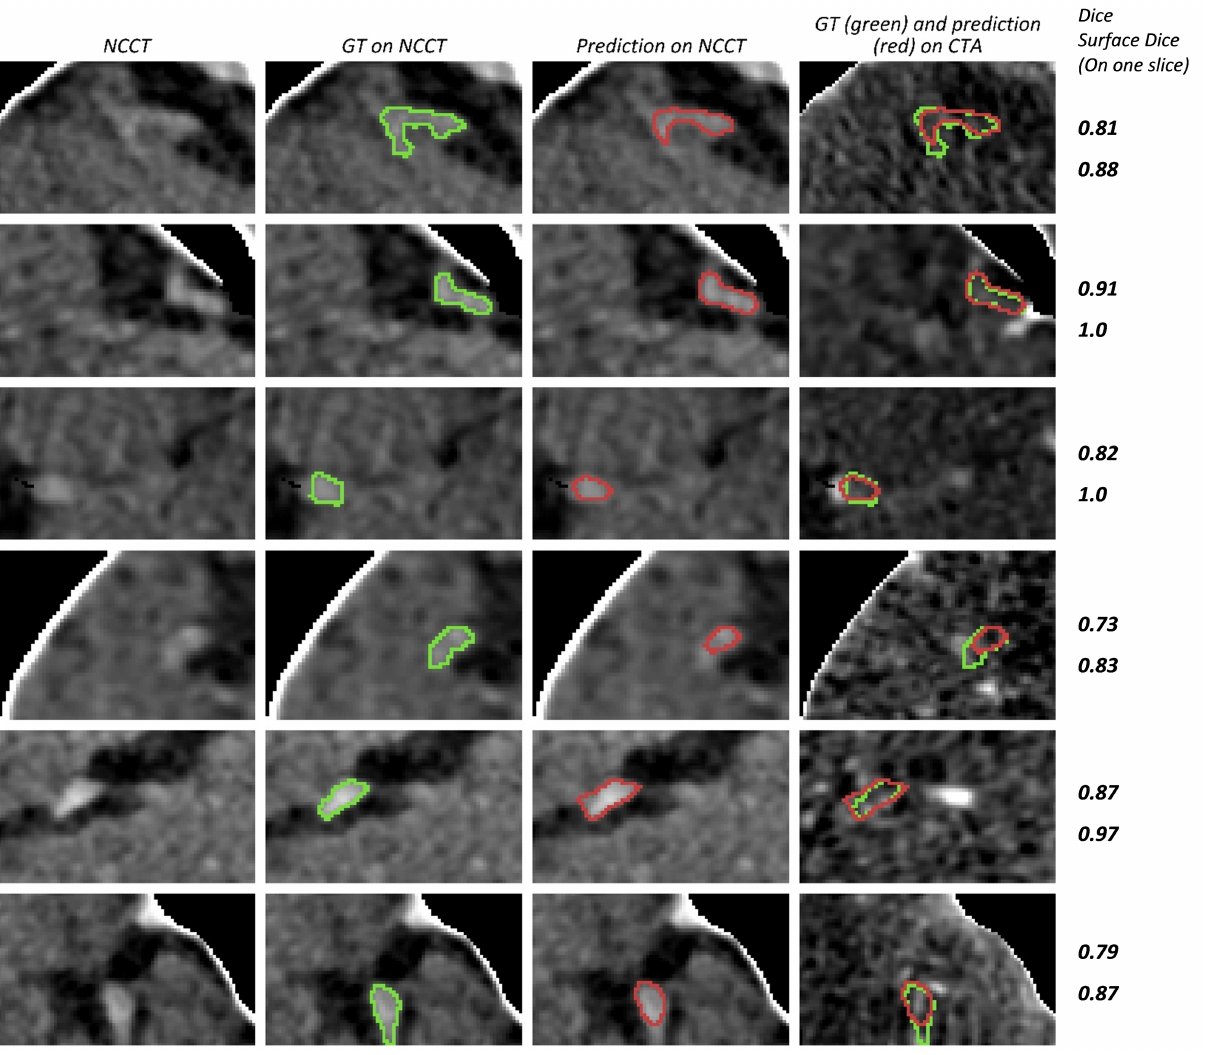
Figure 9. Examples of cases with a Dice score higher than 0.6. The bounding box is used to limit the scan area for each case. Since the bounding box is three-dimensional, only the axial slice with the largest ground truth surface area is depicted. Different cases are represented in rows. The first three columns show NCCT and the right most image column shows the CTA image. The boundaries of the ground truth annotation (GT) and segmentation prediction (prediction) are shown in green and red, respectively. Dice and surface Dice values for the displayed 2D slice are shown at the right side for each